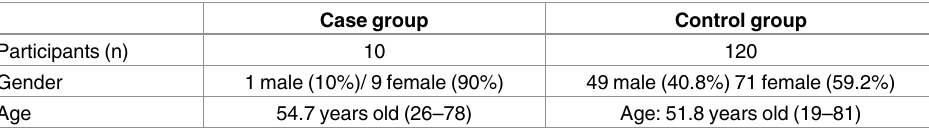
Table 1. Distribution of case and control